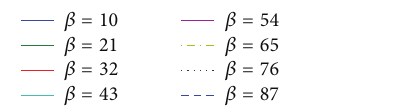
Figure 13: The maximum error value of 𝛽 in a complete 360-degree rotation of the azimuth of lightning source while the distance to antenna sensors is varied from 1km to 4000 km with 34 steps for 8 different elevation levels.